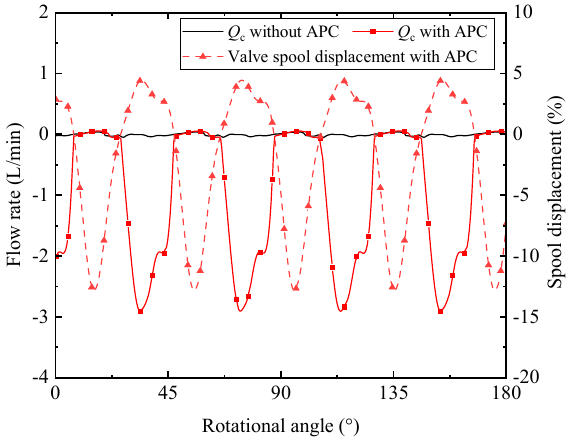
Figure 9. The effect on the flow from actuator piston chamber and spool displacement. Once the control flow alters, the movement of the swash plate is changed. As another part of control mechanism, the counter piston executes reciprocal movement along with the swash plate oscillation. This can be observed by the velocity of counter piston in a red dashed line with triangle mark as shown in Figure 10. The red solid line with square mark represents the flow rate from the counter piston with APC, which shows the opposite variation of the velocity. The positive value of the velocity means the increasing swash plate angle. Once the swash plate angle increases, the flow rate flows from the discharge port to the counter piston chamber, and vice versa. Additionally, the small flow rate without APC can be seen from this figure. The flow rate is likely to be related to the amplitude of the swash plate oscillation according to Equation (16).